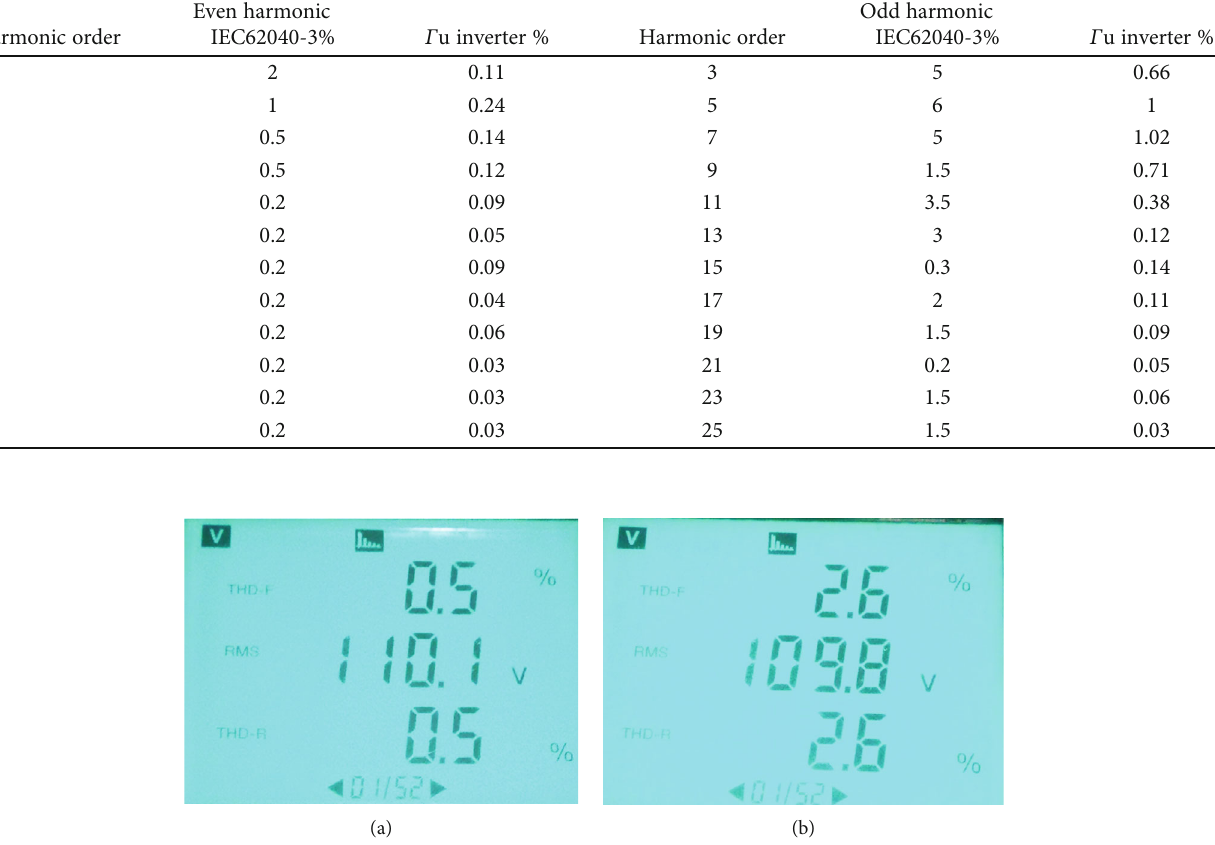
Figure 20: Experimental THD in linear load (a) and nonlinear load (b).